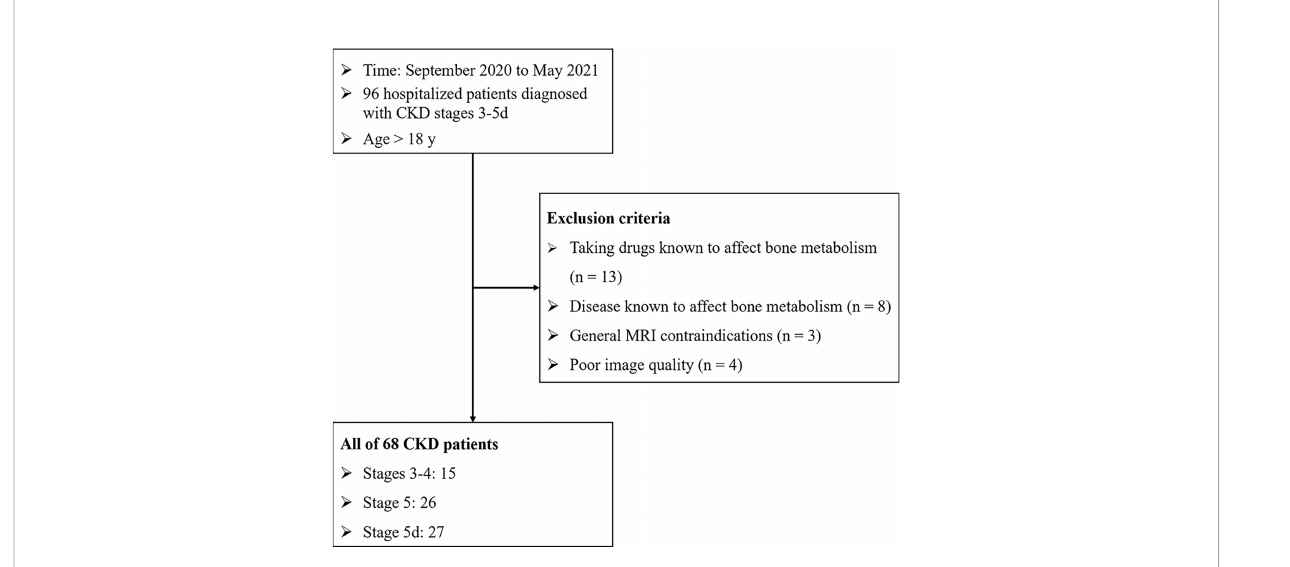
FIGURE 1 Flow chart of patient inclusion and